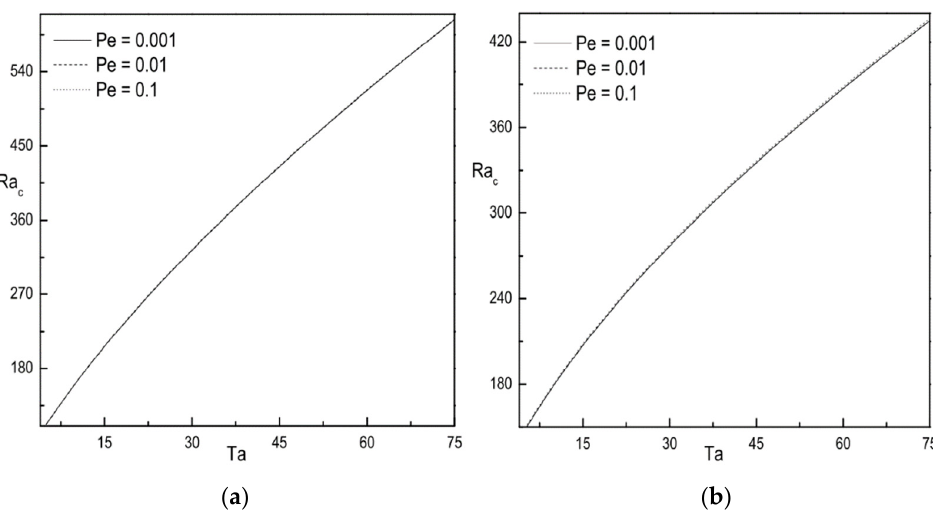
Table 5. Critical Rayleigh number for upward throughflow fixed at Q = 2.